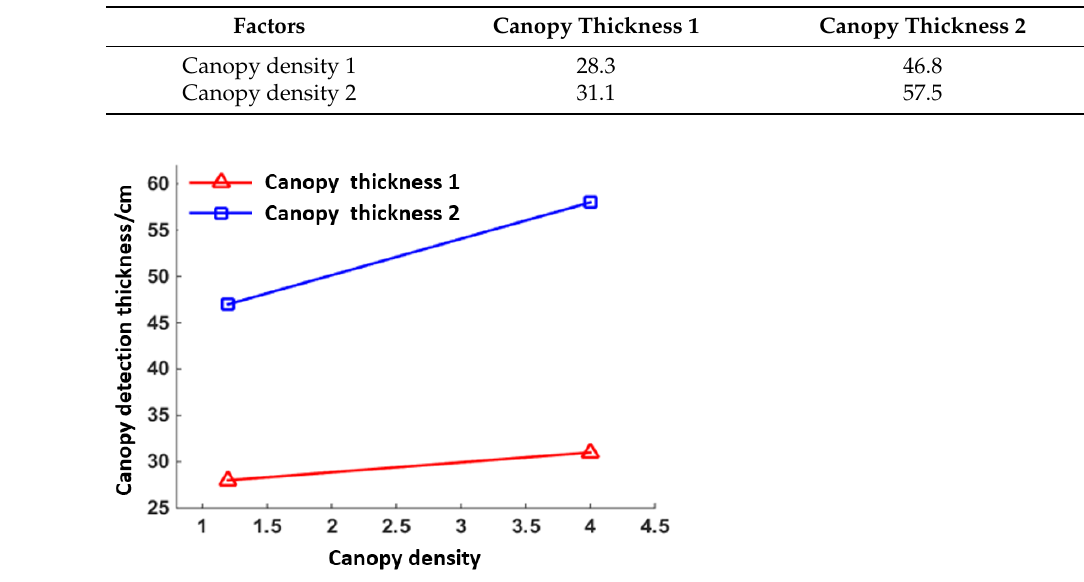
Figure 8. Interaction between canopy density and canopy thickness.